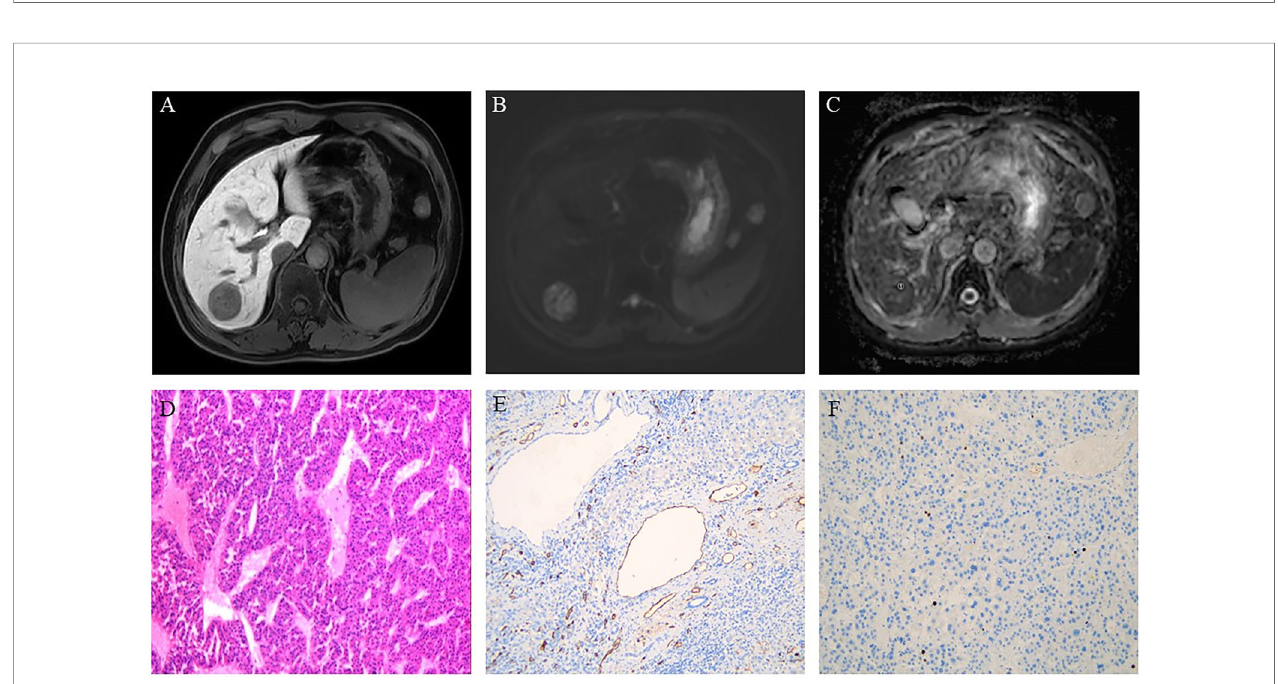
FIGURE 3 | Hepatocellular carcinoma in a 61-year-old man showing a round segment VI mass in the liver. (A) Axial lesions in the hepatobiliary phase showing low signal intensity relative to the hepatic parenchyma. (B) Diffusion-weighted images of axial lesions showing relatively high signal intensity. (C) Apparent diffusion coef fi cient (ADC) map showing the region of interest used to determine the minimum ADC (1). (D) Pathology revealing moderately differentiated hepatocellular carcinoma (HE×100). (E) Immunohistochemistry showing an absence of microvessel invasion by the tumor tissue. (F) Immunohistochemistry showing low proliferative activity of the tumor cells with approximately 3% Ki-67